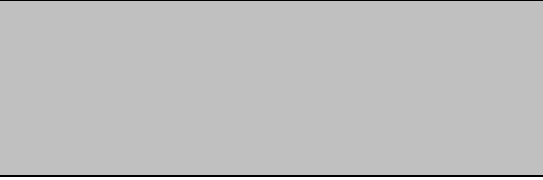
Table III : Mean rate of urinary output (ml/min)